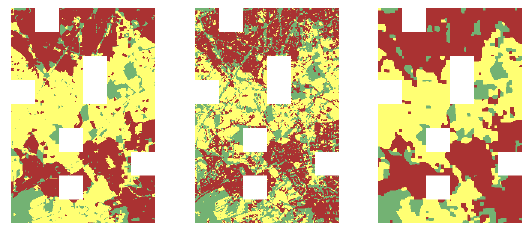
Figure 4. left: Reference of full test scene (Landsat); middle: Results of ML ; right: Results of CRF multi : yellow: crp ; green: for ; dark red: bui; white patches: training